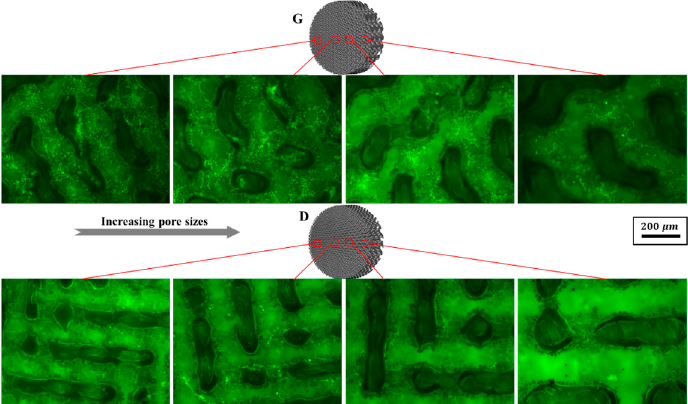
Figure 16. Representative fluorescein diacetate (FDA) staining fluorescence images of osteoblasts adhering to Gyroid and Diamond scaffolds with consecutive gradient in cell-sizes ranging from 0.6 to 2 mm, scale bar: 200 μ m.